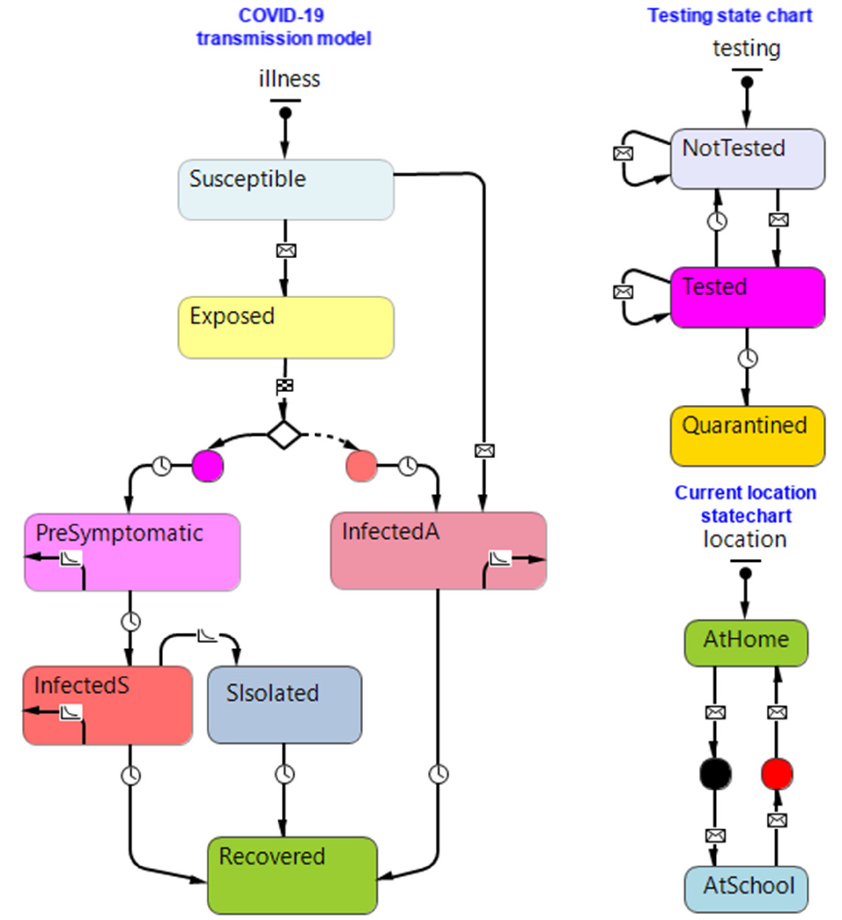
Figure 1. Student agent state charts (disease transmission—( left ), testing—( top right ) and location— ( bottom right )) [4].